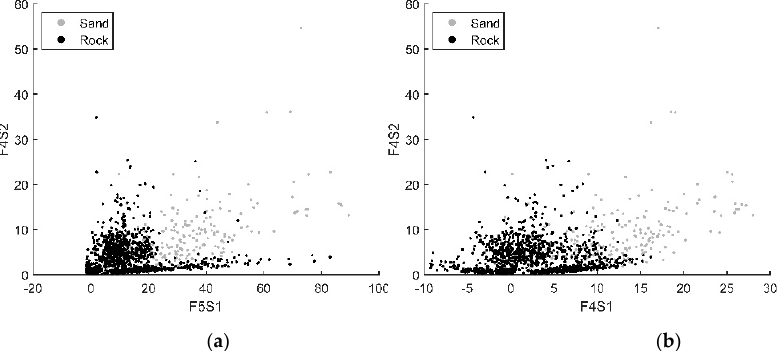
Figure 7. 2D distribution of the most relevant features selected for the terrain classifier: F4S2-F5S1 plane ( a ), F4S2-F4S1 plane ( b ).